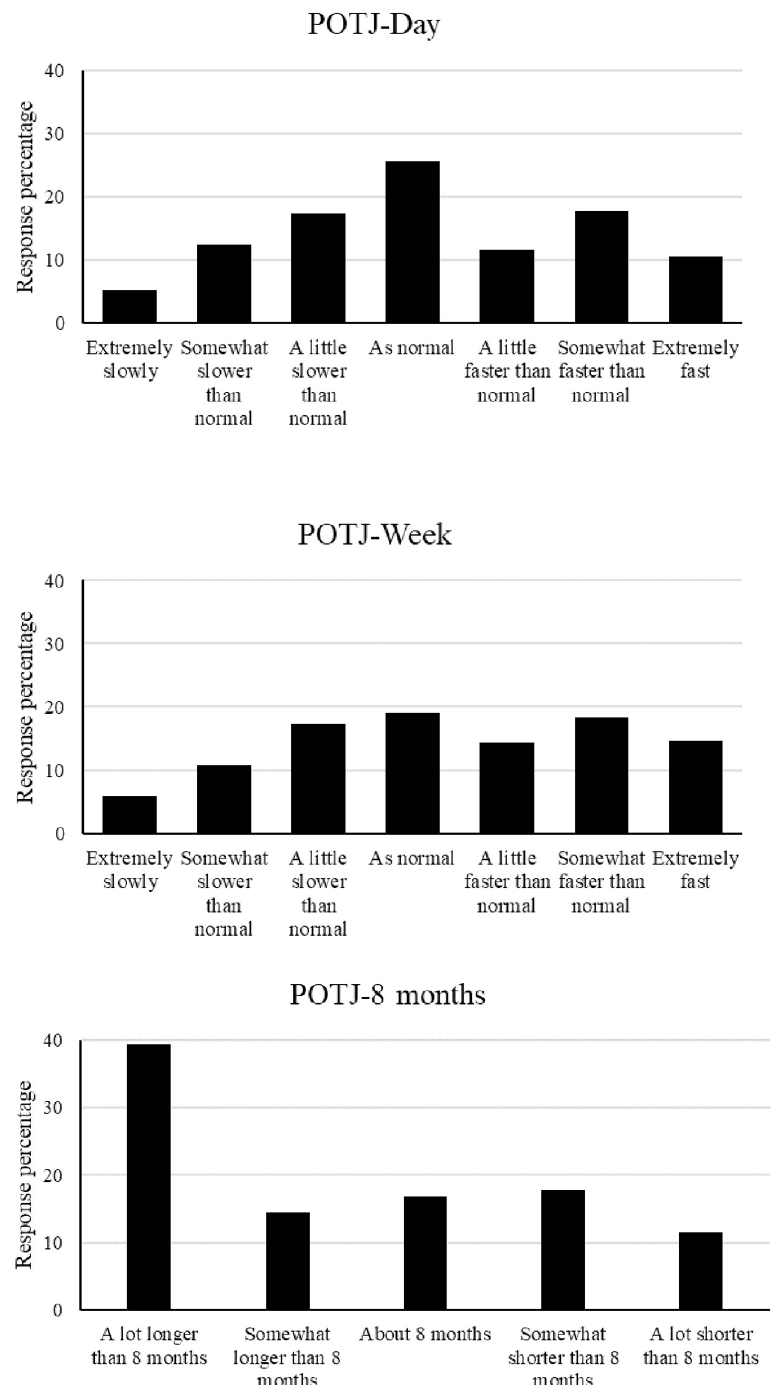
Fig 1. The frequency of responses for each Likert point for the day judgement (upper panel), week judgment (middle panel) and 8-month judgment (lower panel).